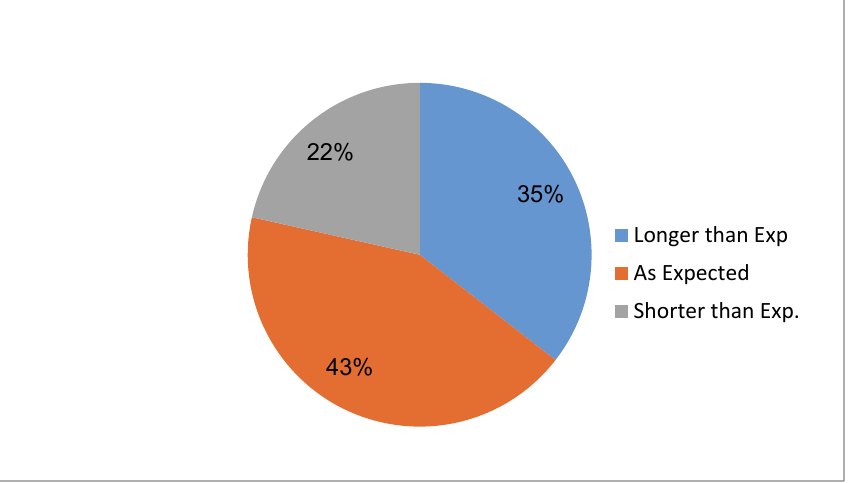
Fig. 5. Trends in time taken for ERP implementations in SMEs (source: Saini et al., 2013)